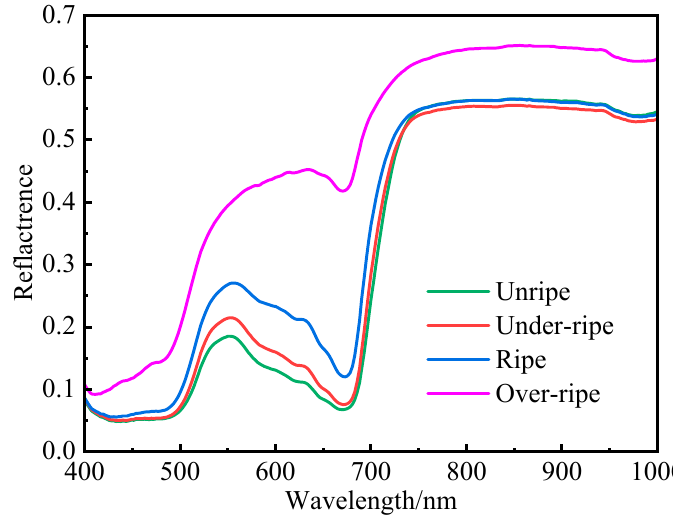
Figure 3. Original spectral curves of tobacco leaves at di ff erent maturity